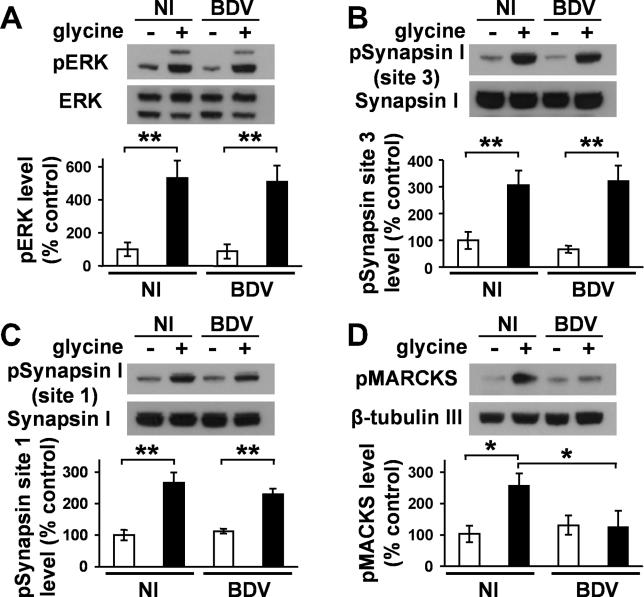
PKC Signaling Is Impaired in BDV-Infected NeuronsWestern blots of neuronal extracts from NI and BDV-infected cultures stimulated with glycine using antibodies specific for: (A) Diphosphorylated ERK 1/2 (pERK) and total ERK 1/2; (B) phospho-synapsin I (pSynapsin I; Site 3, a site specific for CaMK II), and total synapsin I; (C) phospho-synapsin I (Site 1, a site specific for PKA and CamK I) and total synapsin I; (D) phospho-MARCKS (pMARCKS; PKC site at Ser152/156) and β-tubulin III. Results are representative of four independent experiments. Single asterisk (*) indicates p < 0.05; double asterisks (**) indicate p < 0.01 by unpaired t test.